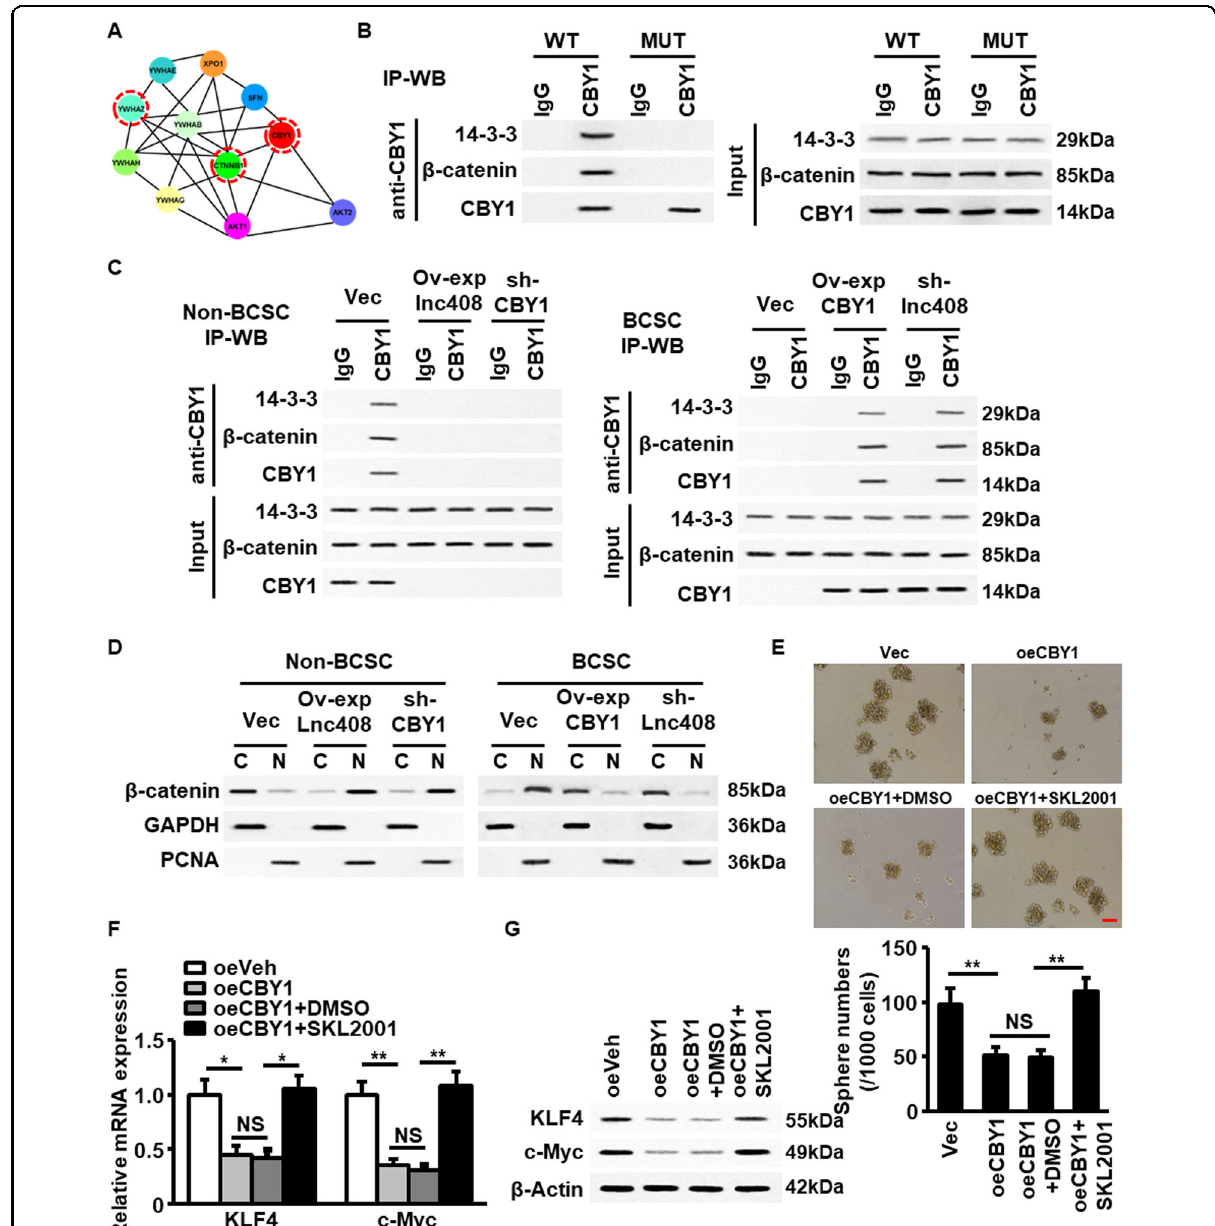
Fig. 6 Lnc408-mediated CBY1 decrease triggers WNT signaling and promotes self-renewal and stemness maintenance of BCSCs. A A protein networks showing the potential interaction among 14-3-3 (YWHAZ), β -catenin (CTNNB1), and CBY1. B HEK293T cells were transfected with an expression vector encoding wild-type CBY1 (WT) or mutant CBY1 (S20A). Immunoprecipitation and western blotting were conducted with antibodies against 14-3-3, β -catenin, and CBY1 to detect the interaction of CBY1, 14-3-3, and β -catenin. C IP-WB was used to detect the ternary complex of CBY1, 14-3-3, and β -catenin in non-CSC derived from of BT549, non-CSC transfected with ectopic lnc408 (oelnc408), and non-CSC with silenced CBY1 (sh- CBY1); or in CSC derived from BT549, CSC transfected with ectopic CBY1 (oeCBY1), and CSC with silenced lnc408 (sh-lnc408). D Western blotting to check the cellular distribution of β -catenin as in C (C cytoplasm, N nucleus). GAPDH served as a cytoplasm control, and PCNA as a nucleus control. E The mammosphere-forming abilities of BT549, BT549 transfected with CBY1 (oeCBY1), or BT549/ocCBY1 cells treated with or without SLK2001 (WNT/ β -catenin agonist, 10 μ M) were tested under suspended culture. The down panel shows the statistical results of mammosphere numbers as means ± SD (** P < 0.01; NS none signi fi cance; scale bar, 100 μ m). F , G The mRNA and protein expressions of breast cancer pluripotent factors (KLF4, c- Myc) were determined by qRT-PCR ( F ) and western blotting ( G ), respectively (* P < 0.05; ** P < 0.01; NS none signi fi